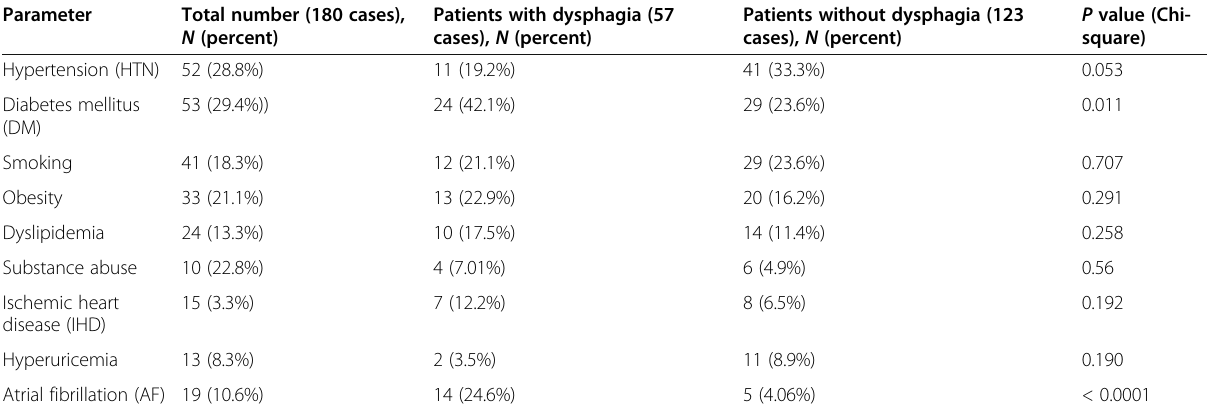
Atrial fibrillation (AF) 19 (10.6%) Multivariable regression analysis results